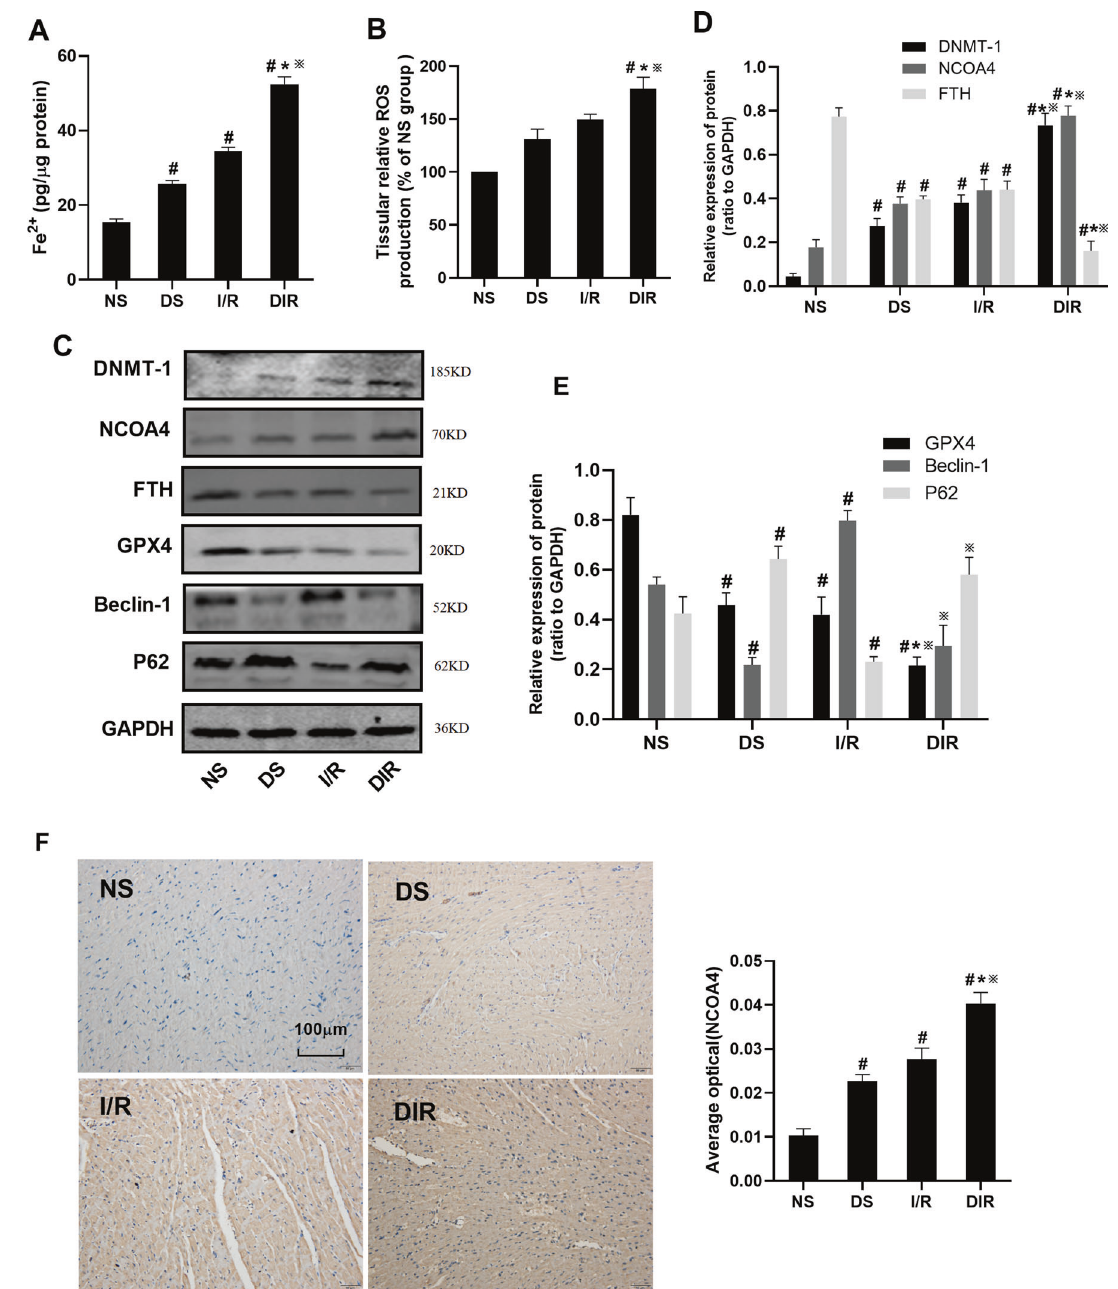
Fig. 2 The level of DNMT-1 and ferritinophagy-ferroptosis axis in DS, I/R, and DIR rats. A Fe 2 + in myocardial tissue was detected. B ROS in myocardial tissue was detected. C – E The protein expression of DNMT-1, NCOA4, FTH, GPX4, Beclin-1, and p62 in myocardial tissue was detected by western blotting. F The expression of NCOA4 in myocardial tissue was detected by IHC. Results are presented by means ± SD. n = 8 per group. # P < 0.05 compared with the NS group. * P < 0.05 compared with the DS group. ※ P < 0.05 compared with the I/R decreased ( P < 0.05), when compared with the HH/R group. The After 5-aza-CdR intervention, the number of autophagosomes immuno fl uorescence was further used to detect the expression of further increased. As shown in Fig. 5B, C, compared with the HG NCOA4 and GPX4 proteins. Moreover, ferritinophagy was detected group, the protein expression of GPX4 and FTH in the HH/R group by LC3 and NCOA4 colocation. As shown in Fig. 6, compared with was decreased ( P < 0.05). The protein expression of NCOA4 and the HG group, autophagy-related molecular LC3 in the HH/R DNMT-1 was increased ( P < 0.05). When compared with the HG group was increased slightly, but this was not statistically group, the protein level of Beclin-1 was increased and the protein signi fi canct. The level of NCOA4 was increased ( P < 0.05). level of P62 was decreased, but this was not statistically Compared with the HH/R group, the level of LC3 was increased signi fi cant. After being intervened with 5-aza-CdR, the protein in the HH/R + 5-aza-CdR group and the level of NCOA4 was expression of FTH, Beclin-1, and GPX4 was increased ( P < 0.05). decreased ( P < 0.05). As shown in Fig. 7A, B, compared with the HG The protein expression of DNMT-1, NCOA4, and P62 was